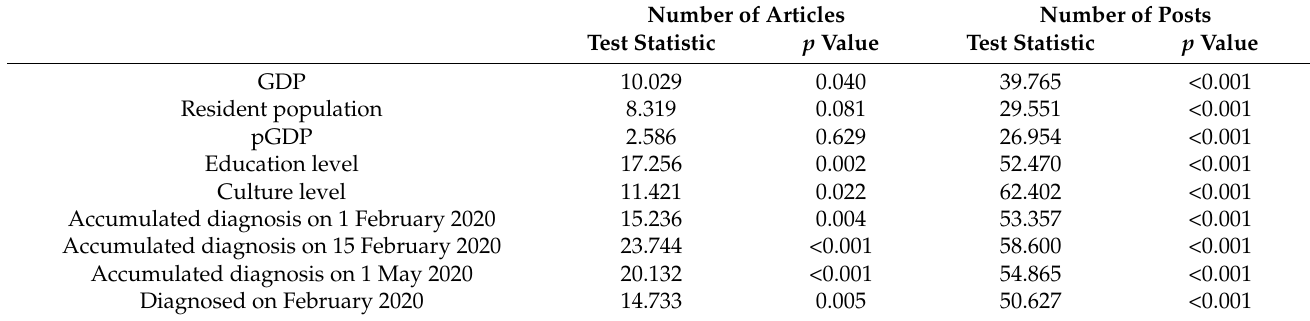
Figure 4. Effects of different types of articles on emergency response and risk communication. Note: The comparison of ( a ) NA, ( b ) ARQ and ( c ) AWQ at different types of articles.